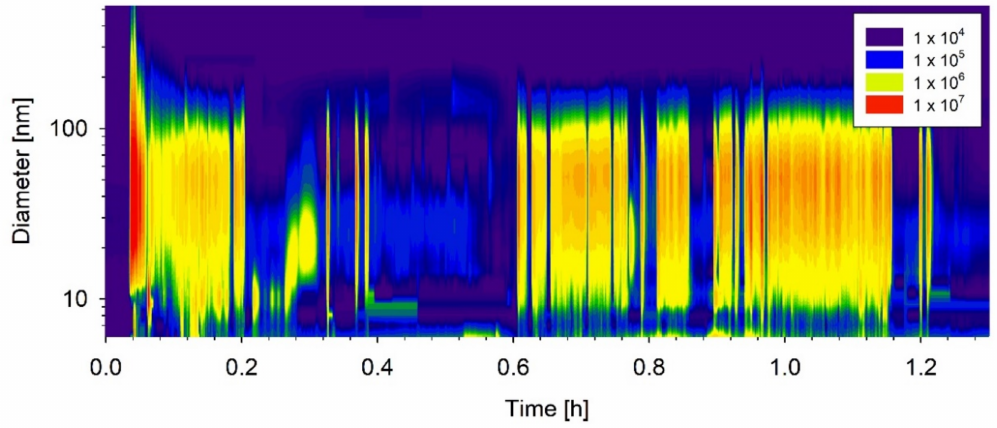
Figure 9. Development of the particle size distribution during real-drive test no. 1 (EEPS). The concentration is given in #/cm 3 and in a